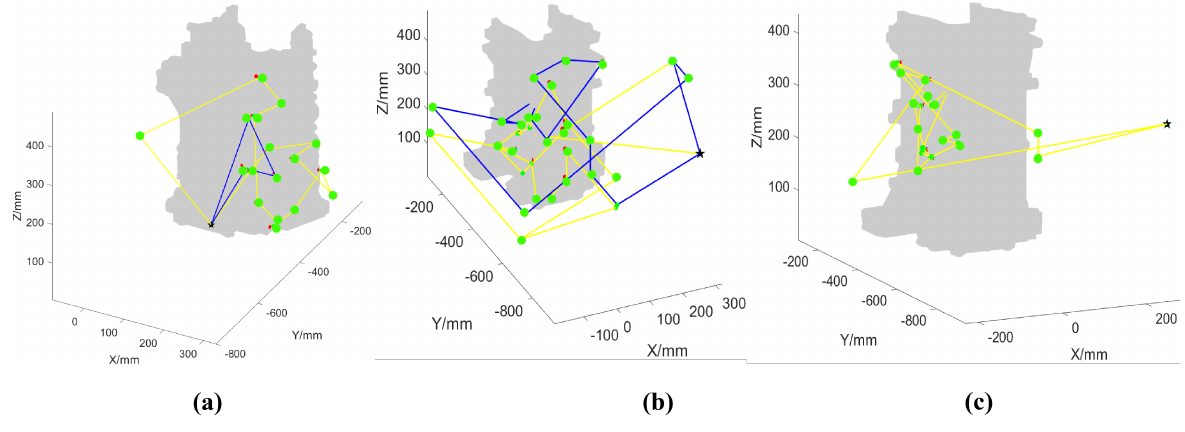
Figure 13. Inspection path diagram based on DSV algorithm. ( a ) Collision-free path for groups 1–2, in which yellow line represents the path of S 1 and blue line represents the path of S 2 . ( b ) Collision- free path for groups 3–4, in which yellow line represents the path of S 3 and blue line represents the path of S 4 . ( c ) Collision-free path for group